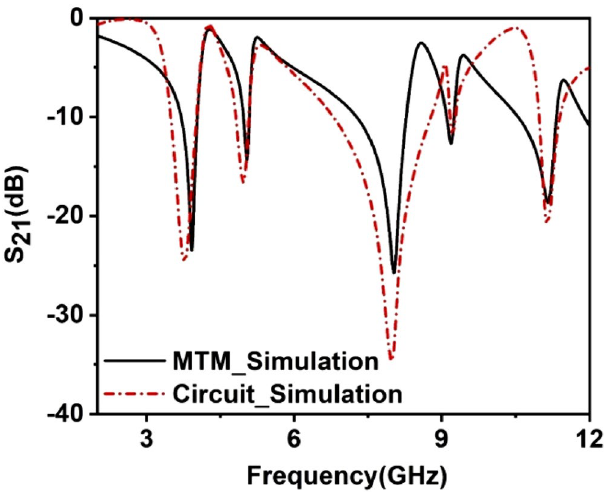
Figure 9. Transmission coefficient obtained from the equivalent circuit simulated in ADS and CST simulation.